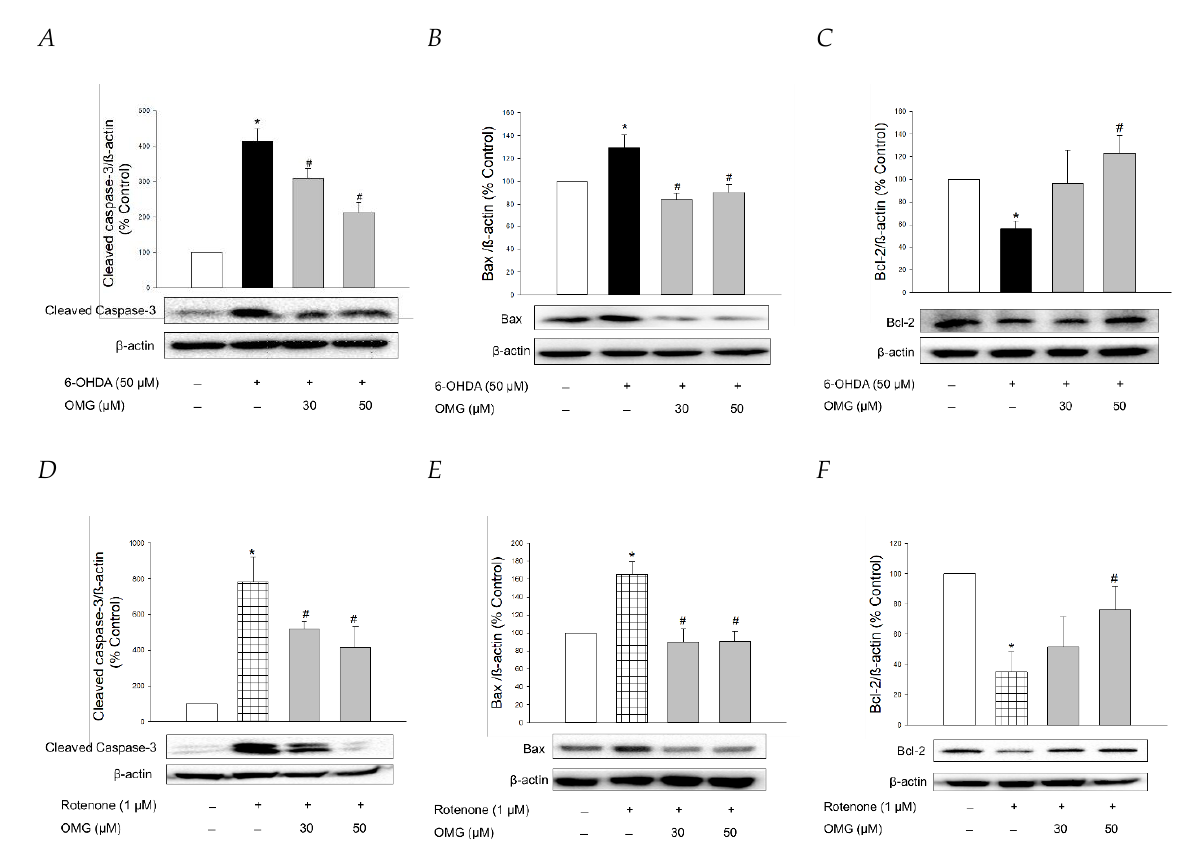
Figure 9. Anti-apoptotic properties of OMG in 6-OHDA- or rotenone-treated PC12 cells. PC12 cells were pretreated with OMG (30 and 50 µ M) for 4 h, subsequently exposed to ( A – C ) 6-OHDA or ( D – F ) rotenone for an additional 6 h, and the expression levels of ( A , D ) cleaved caspase-3, ( B , E ) Bax, and ( C , F ) Bcl-2 were detected by western blotting, as described in the Materials and Methods sections. Band intensity was quantified by densitometric analyses. β -Actin was used for the normalization of each protein. Representative blots are shown. Data are displayed as the mean ± SEM from at least three independent experiments. *, p < 0.05 and # , p < 0.05 vs. the vehicle-treated control and 6-OHDA- or rotenone-treated cells, respectively. OMG, omarigliptin; 6-OHDA, 6-hydroxydopamine; Bcl-2, B-cell lymphoma 2; Bax, Bcl-2-associated X.